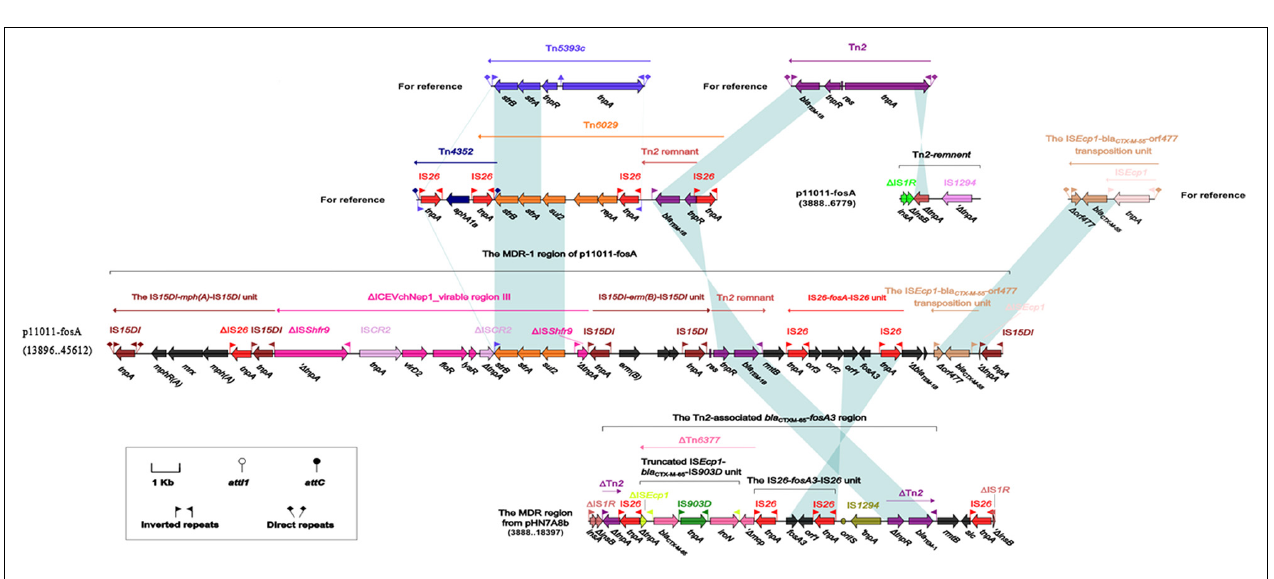
FIGURE 3 | The MDR-1 region of p11011-fosA. Genes are indicated by arrows. Genes, mobile elements and other features are colored based on functional classification. Shadows indicate nucleotide homology is greater than 95%. The number in parentheses indicates the location of the fragment in the plasmid.